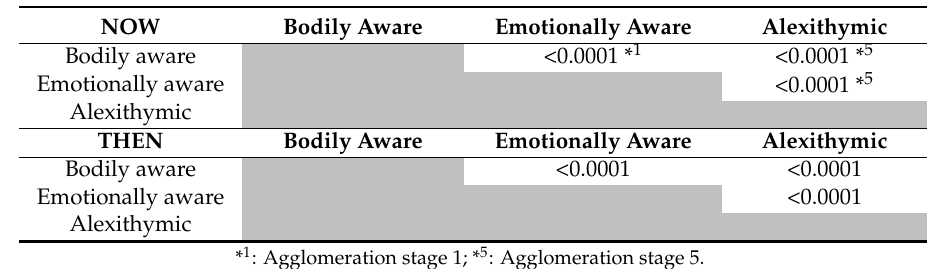
Table A16. Self-awareness.